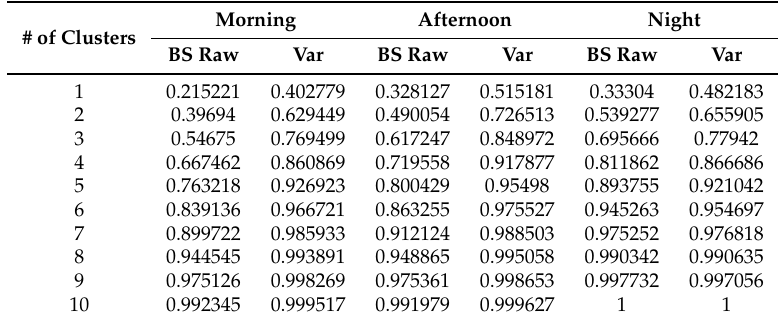
Table 6. Proportion of explained variance in the data by the number of clusters for activity information (all periods of the day) Morning Afternoon Night # of Clusters BS Raw Var BS Raw Var BS Raw